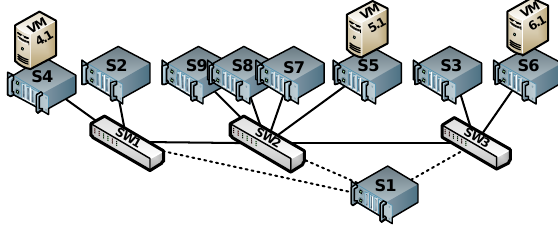
Figure 5: Network topology used in the experiment. Dashed links are used for monitoring, solid links for data traffic. Server S 1 is the experiment